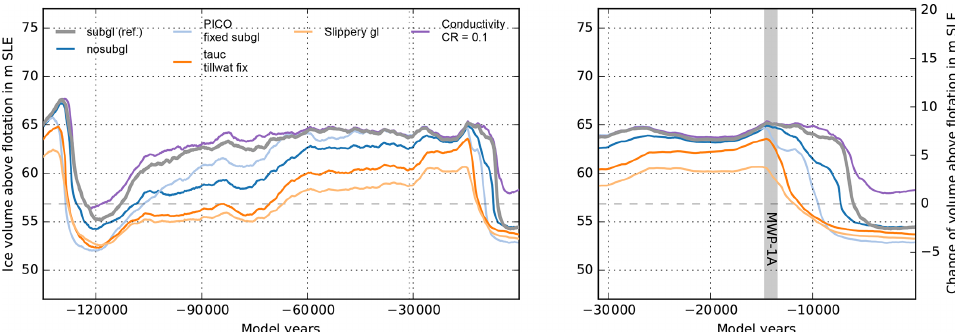
Figure A2. Sensitivity of transient ice volume above flotation to varied conditions at the grounding line. Grey curve is the reference with applied sub-grid basal shear stress and old basal melt interpolation, which generally underestimates melting at the grounding line. Without basal melt interpolation (blue) or with fixed basal melt interpolation (light blue), deglaciation occurs earlier than in the reference, while glacial maximum extent is comparable. Glacial ice sheet growth is even slower for enforced saturated till conditions along the marine sections of the grounding line, landward (orange) or on the ocean side of the grounding line (light orange). The much higher sensitivity of the ice sheet volume to oceanic forcing yields a smaller glacial ice volume and much earlier deglaciation. The effect of variation in the temperate ice conductivity ratio over 4 orders of magnitude has only little effect, with slightly larger interglacial ice volumes for larger ratios